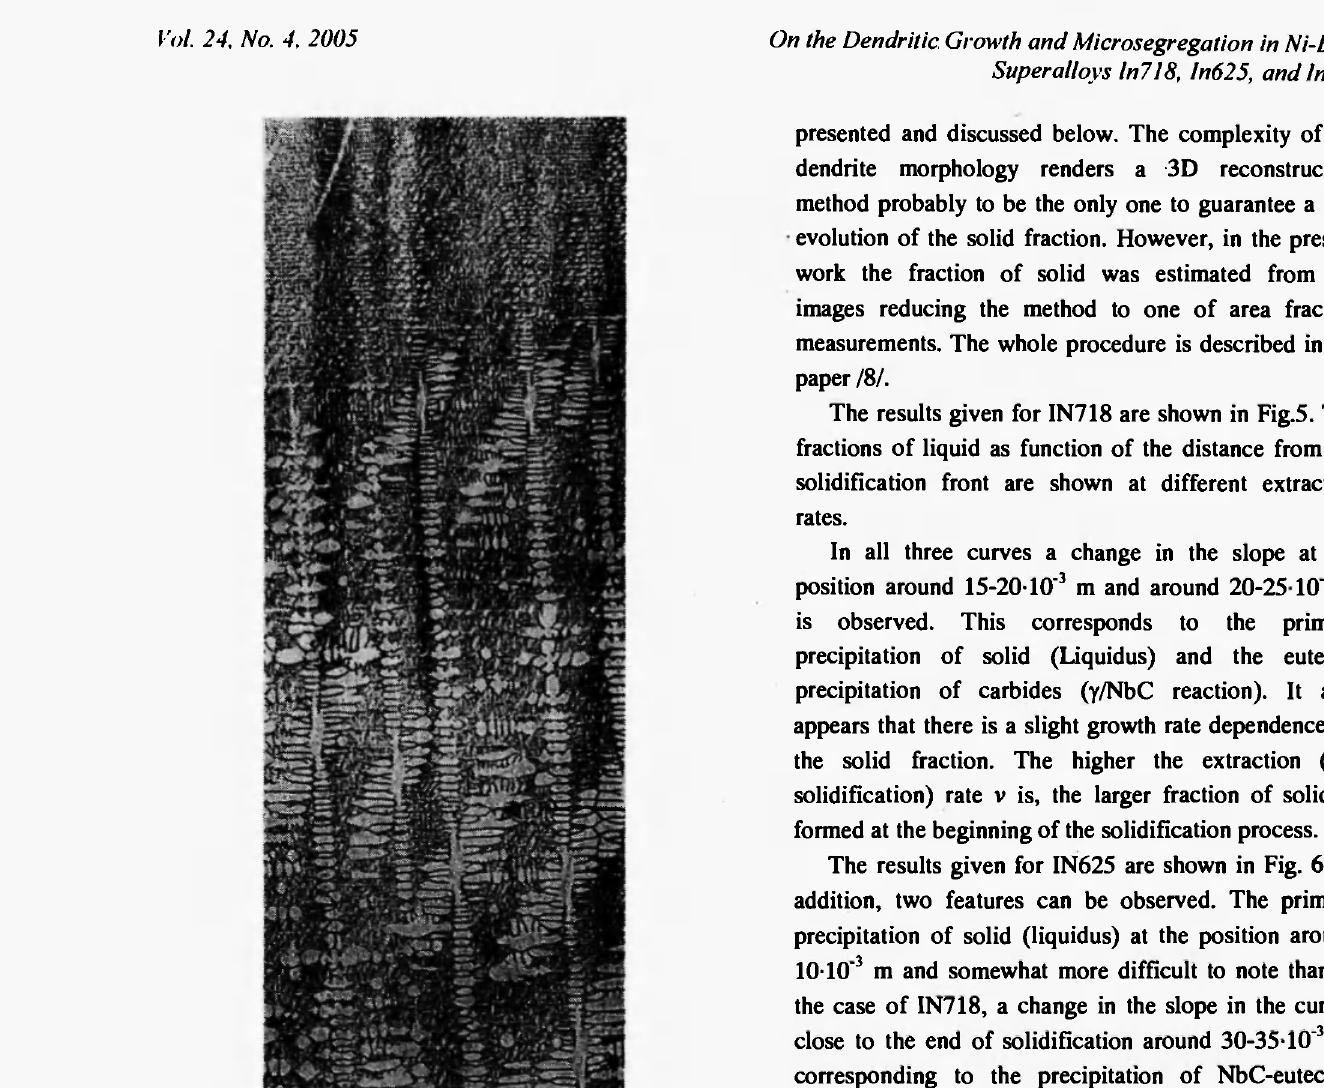
Fig. 4: Microstructure of a DSQ sample (IN7I8 - ν = 100· 10" 6